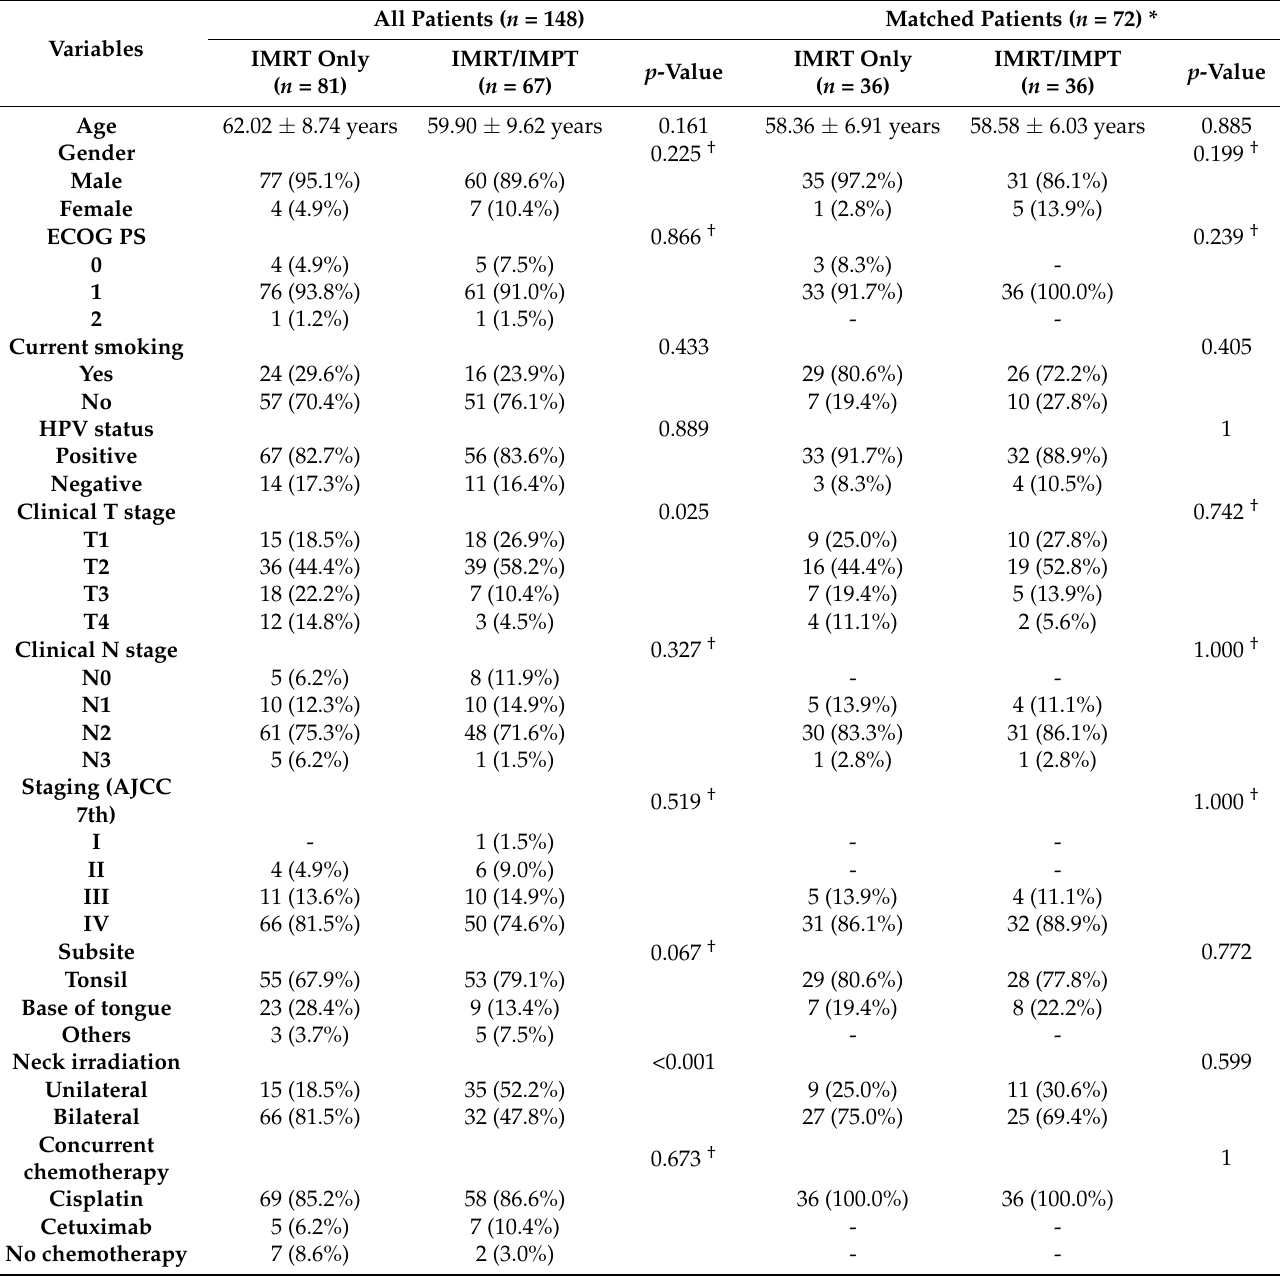
Table 1. Baseline demographic and clinical